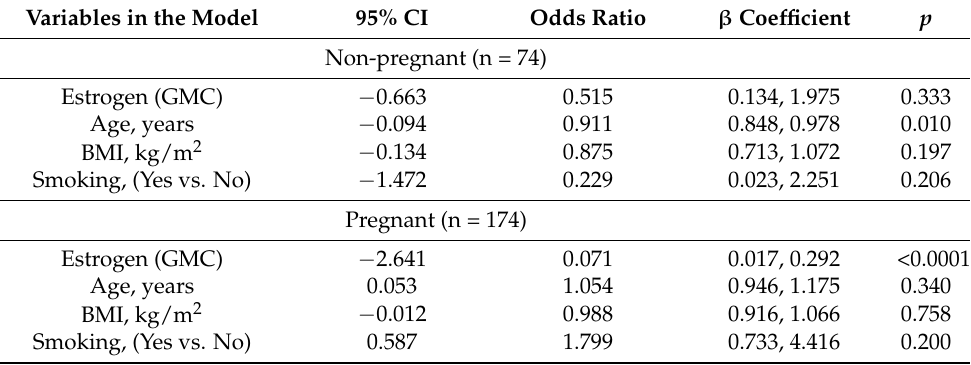
Table 3. Multiple logistic regression analysis for the association between anti-PT IgG antibody levels with estrogen, age, BMI, smoking status in non-pregnant and pregnant women.